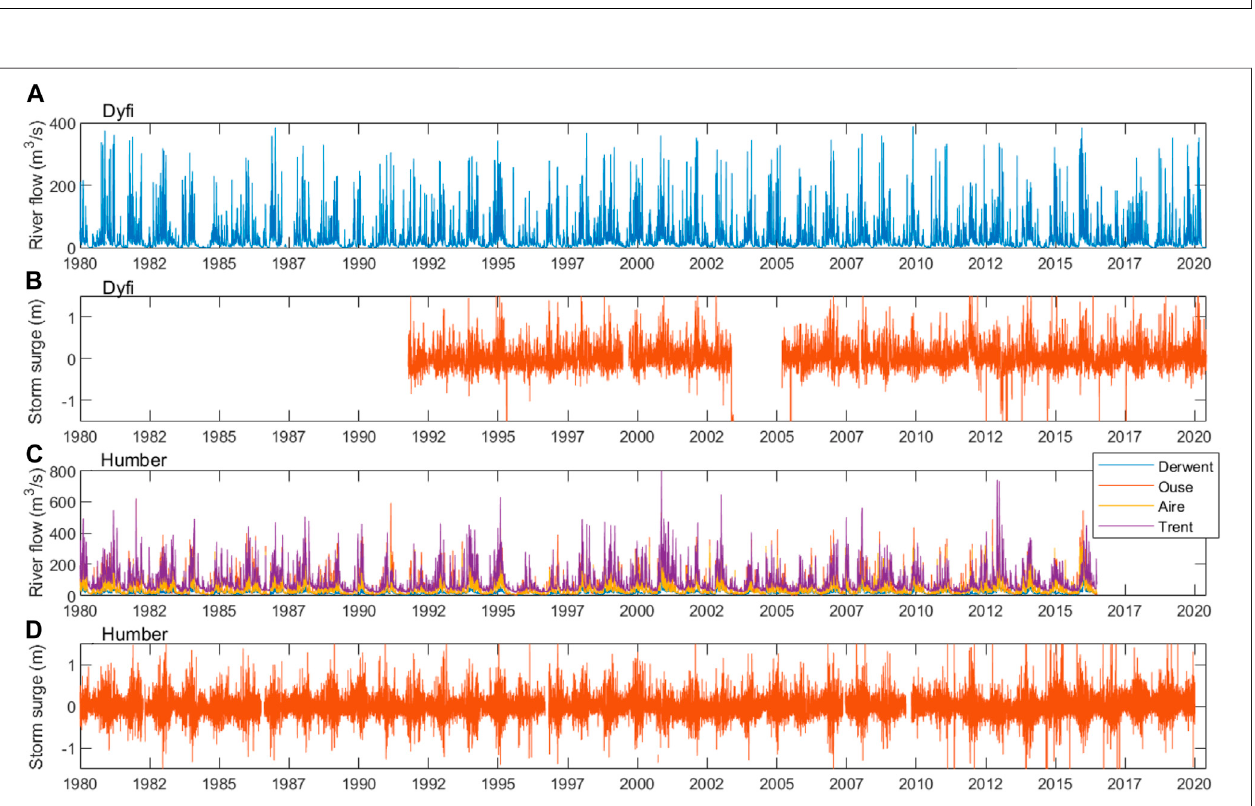
FIGURE 2 | Dy fi : (A) Flow at Dy fi Bridge on the Dy fi (ID: 64001) and (B) storm surge at Barmouth tide gauge. Humber: (C) Flow at Stanford Bridge on the Derwent (ID: 27015), North Muskham on the Trent (ID: 28022), Skelton on the Ouse (ID: 27009) and Beal on the Aire (ID: 27003); and (B) storm surge at Immingham tide gauge.